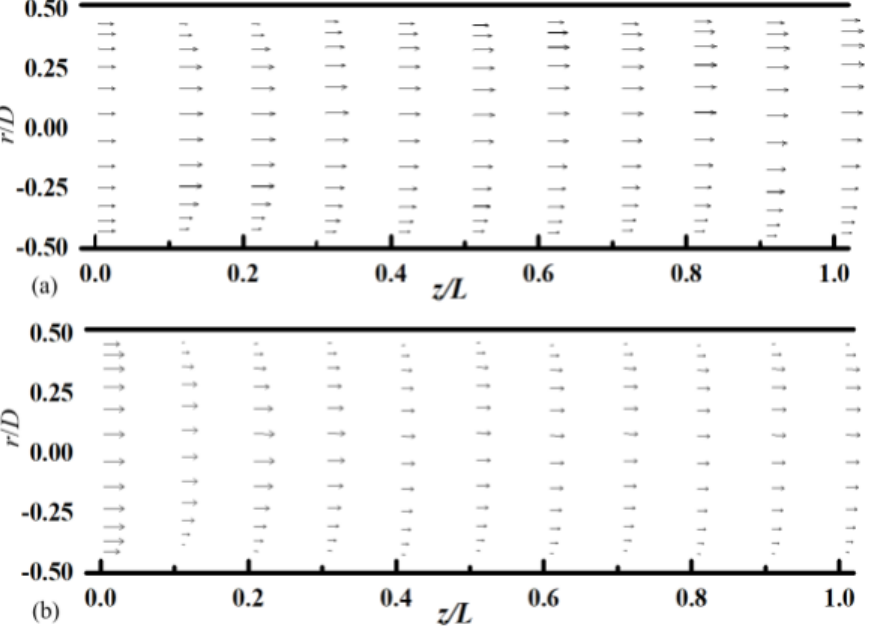
Figure 5. Velocity vector distribution at different sections ( d p = 100 µ m, V = 7 m/s, α s = 5%, m s = 15 t/h). ( a ) gas phase; ( b ) solid